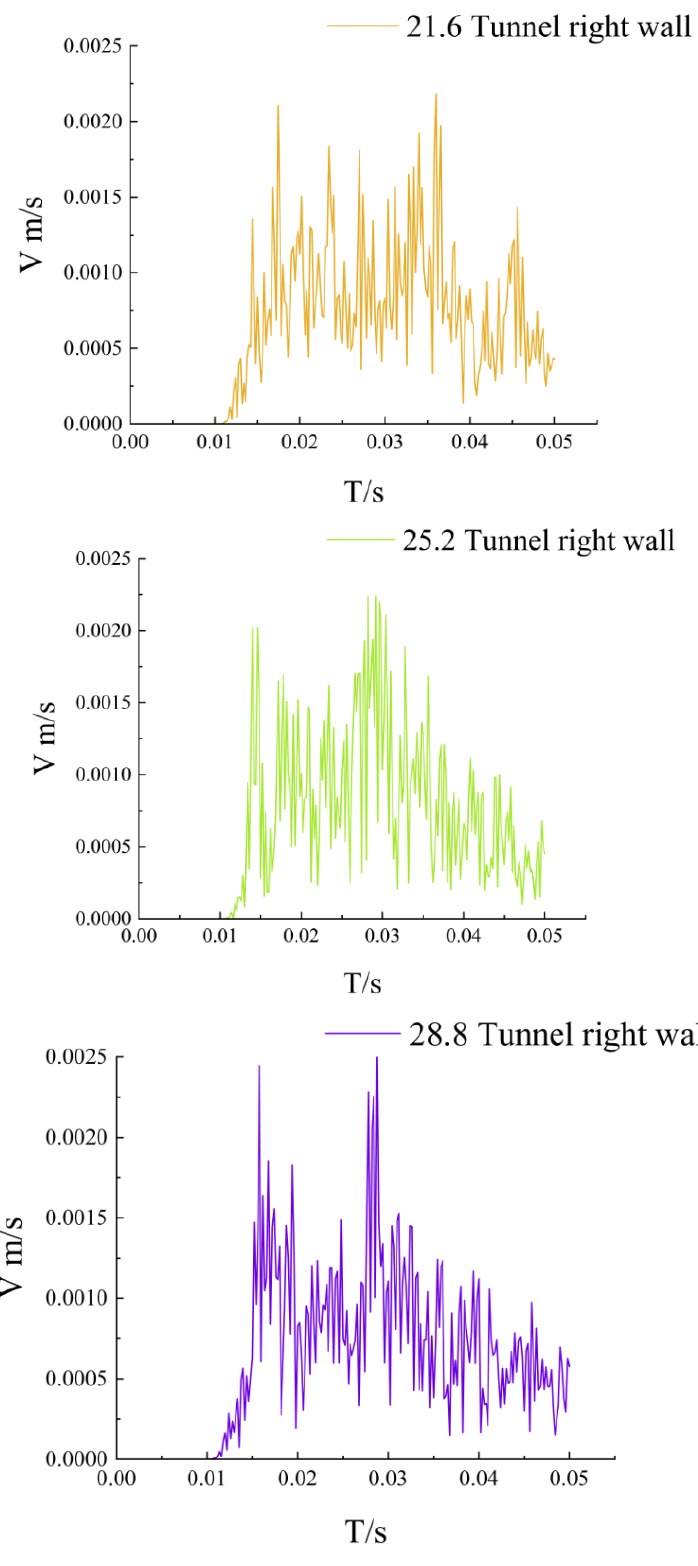
Figure 4. Vibrational velocity curve of the right wall of the plain concrete tunnel.